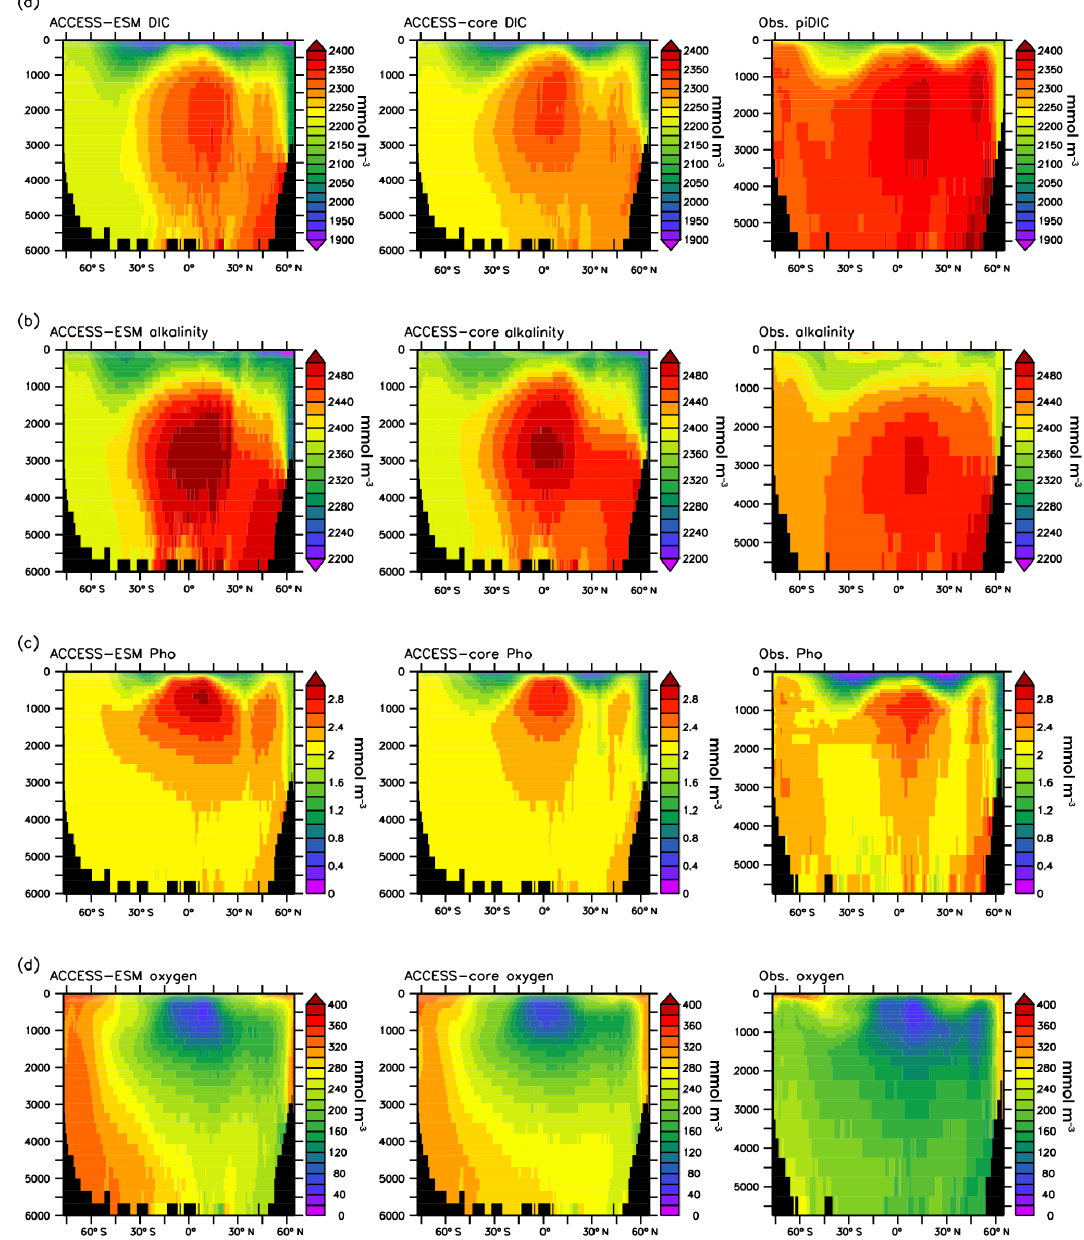
Figure 11. Zonal-averaged sections of ACCESS-ESM1 simulation for the years 901–1000 (left) compared to an ocean-only simulation with CORE forcing (centre) and the observations (right) for (a) DIC in mmolCm − 3 , (b) Alkalinity in mmolEqm − 3 , (c) Phosphate in mmolPm − 3 and (d) Oxygen in mmolOm − 3